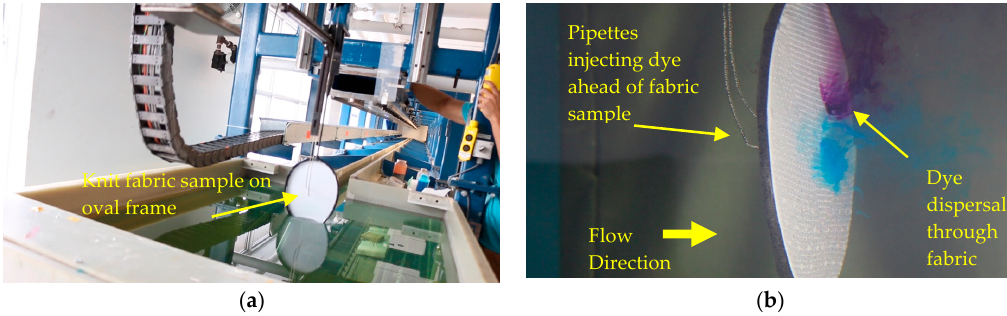
Figure 3. ( a ) Knit fabric sample held in oval frame being submersed in OTTER 1 tow tank; ( b ) Knit fabric sample with dye injection showing dye dispersion through porous openings in